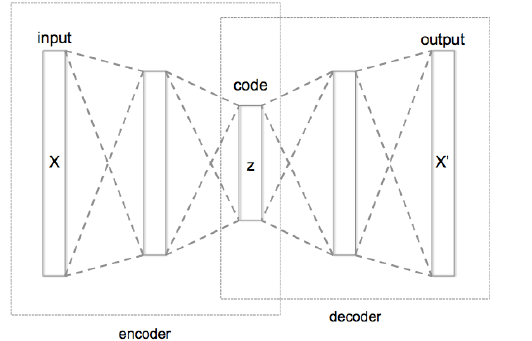
Figure 2. Encoder-Decoder architecture of AutoEncoder.